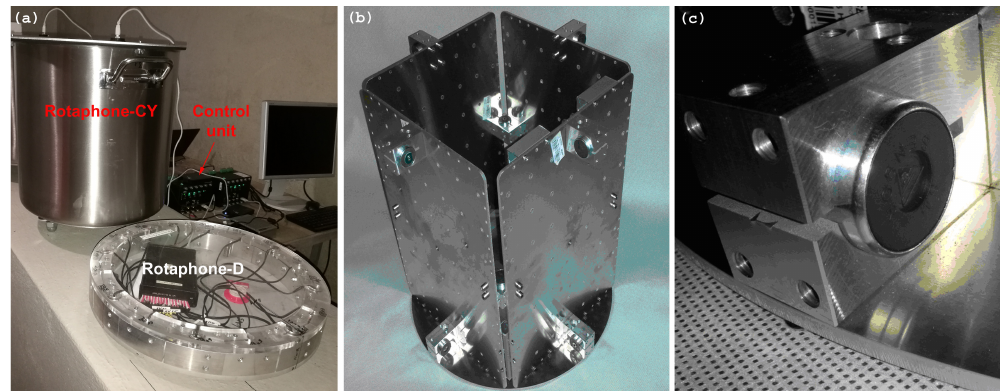
Figure 1. Rotaphone-CY: an overall view of the instrument (compared to the ancestor six-component (6C) Rotaphone-D design) and its control unit ( a ), inner frame with geophones ( b ), and a detail of a horizontal geophone SM-6 mounted to the inner frame ( c ).